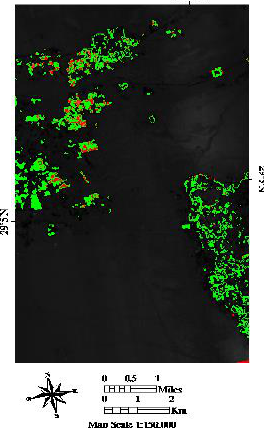
Figure 11. Classification of polluted (red pointes) and unpolluted (green points) regions by SAM algorithm Figure 11 shows the classified image of the case study by SAM technique. According to this figure the contaminated Eucalyptus trees in the region were specified using red points. So the unpolluted ones namely healthy trees were remained in the green